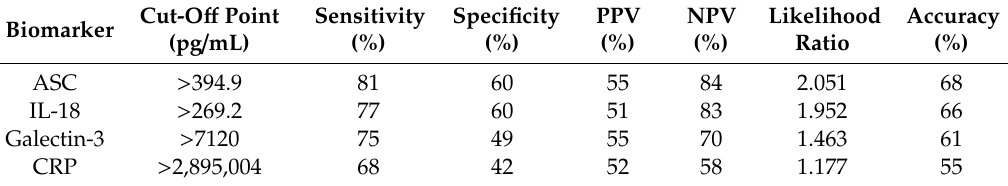
Table 2. Cut-o ff point analyses for signaling proteins in serum as markers of